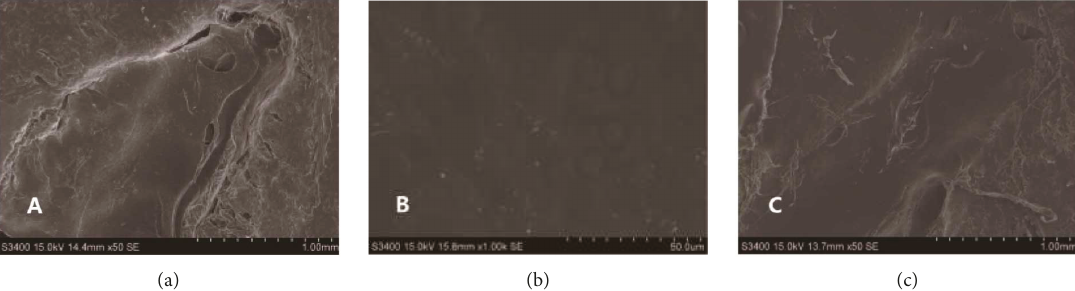
Figure 8: Observation of canine knee patella by SEM: (a) untreated control group ( × 50 SE), (b) normal control group ( × 1000 SE), and (c) treated group ( × 50